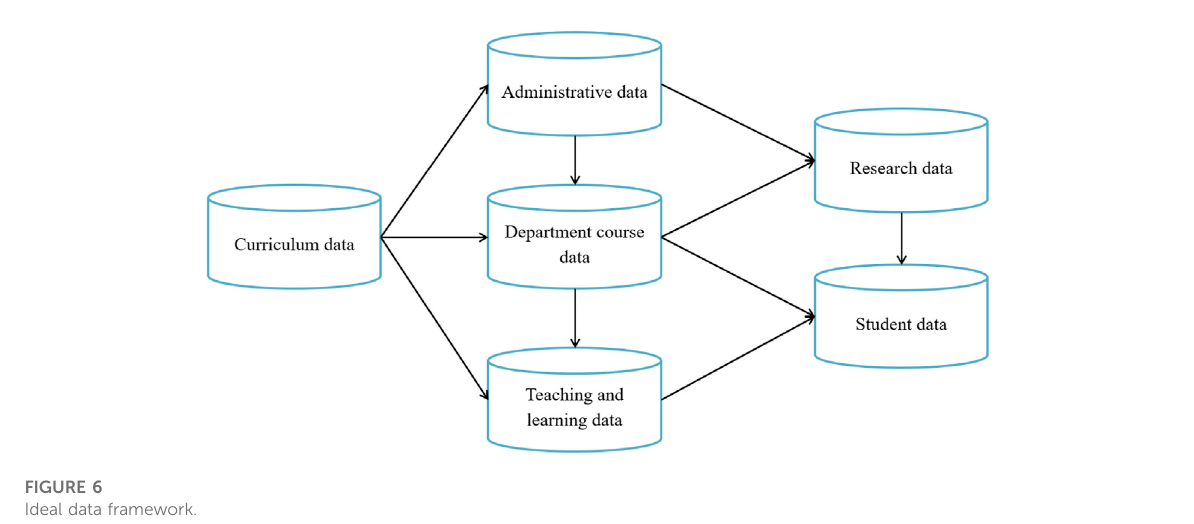
FIGURE 6 Ideal data